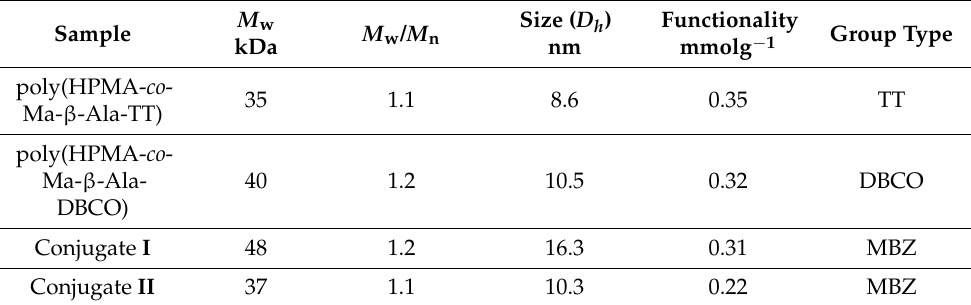
Table 1. Properties of polymer precursors and polymer